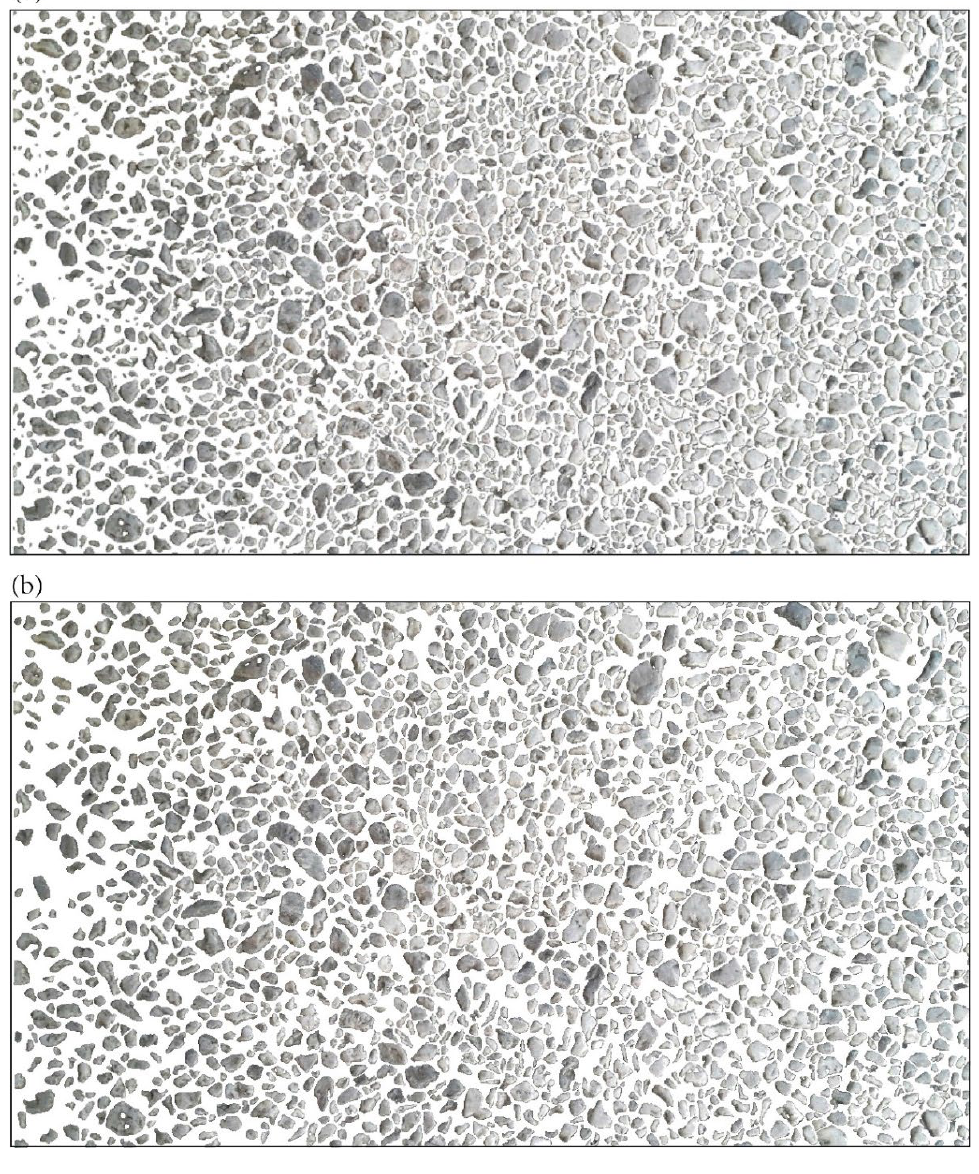
Figure 9. ( a ) The resultant color image converted from its binary-extraction image by the photograph of a sandstone outcrop in the model application. ( b ) The modified image is based on ( a ) using the utility of manual operation. Figure 9a is the gray conversion of binary extraction from the step of model